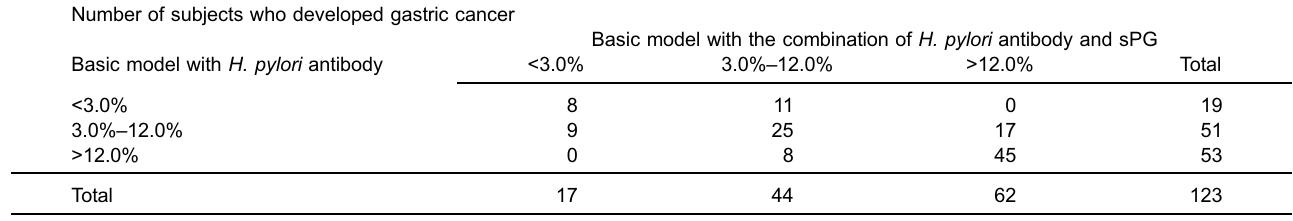
Table 3. Reclassi fi cation for 20-year predicted absolute risk of gastric cancer development Number of subjects who developed gastric cancer Basic model with the combination of H. pylori antibody and sPG Basic model with H. pylori